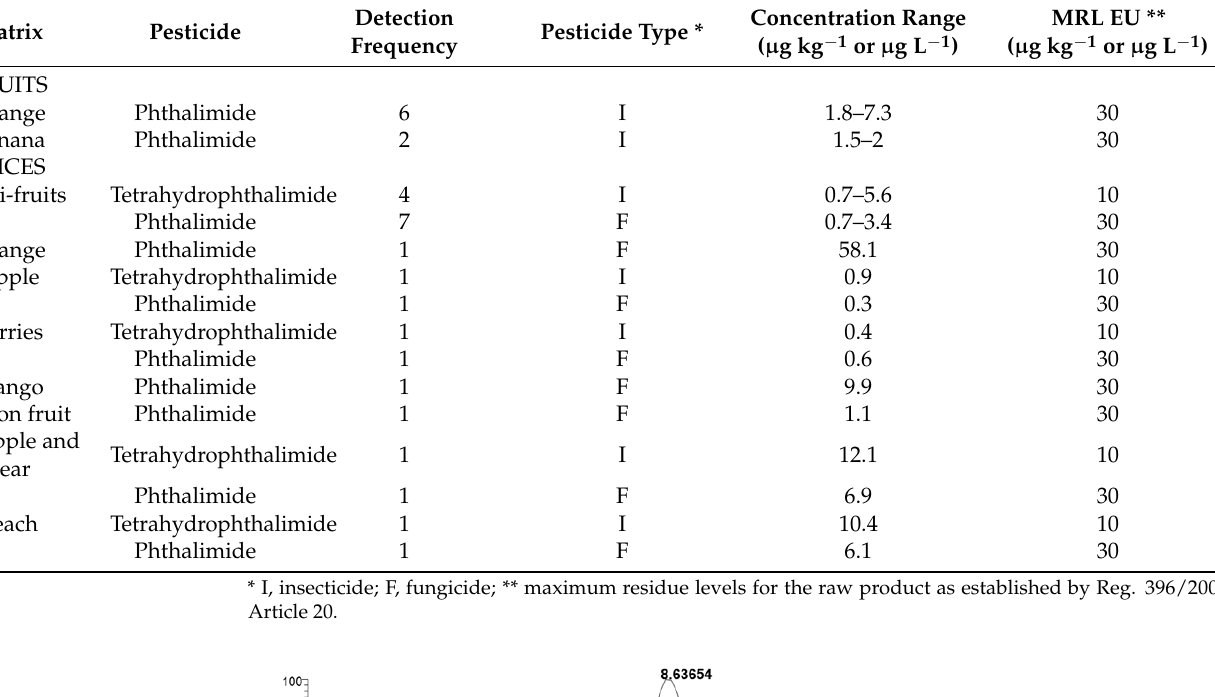
Table 3. Suspect residues detected in fruit and juice samples.